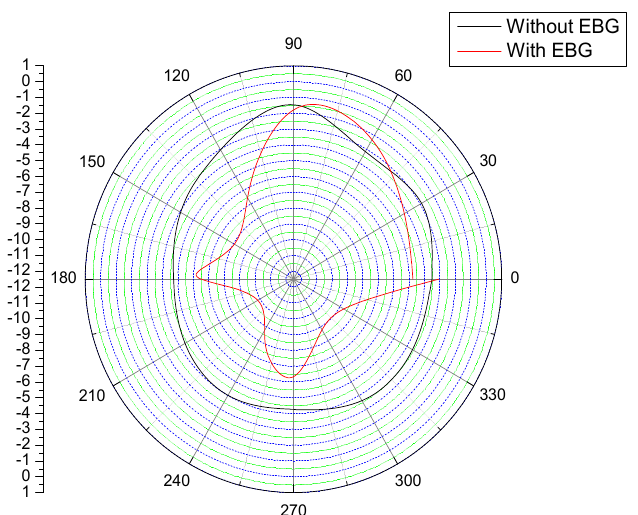
Figure 13. Graph of radiation plots of microstrip antenna arrays without and with star slot EBG